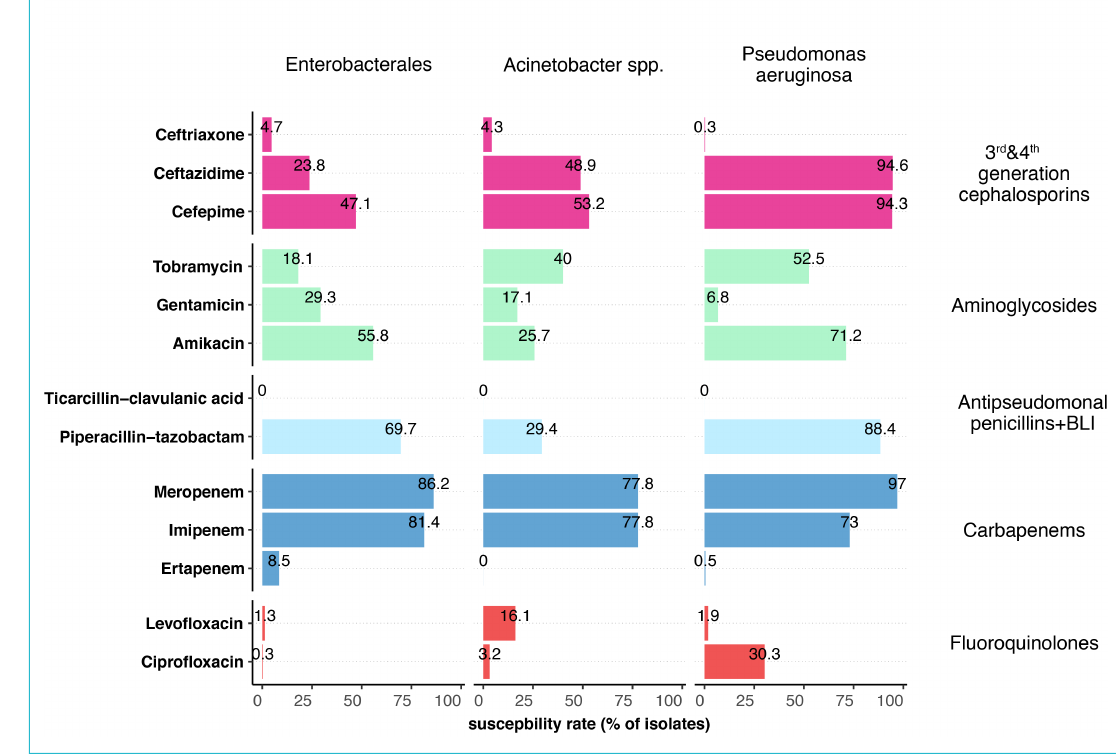
Figure 2: Summary of the cross-resistance situation in the different groups of gram-negative bacteria. To assess cross-resistance within an antibiotic category, only isolates for which all of the most frequently tested antibiotics of a group were analysed and an isolate was resistant to at least one substance in a group were included in this analysis (for the number of isolates included per antibiotic category, see table S3 in the Appendix). BLI, β-lactamase